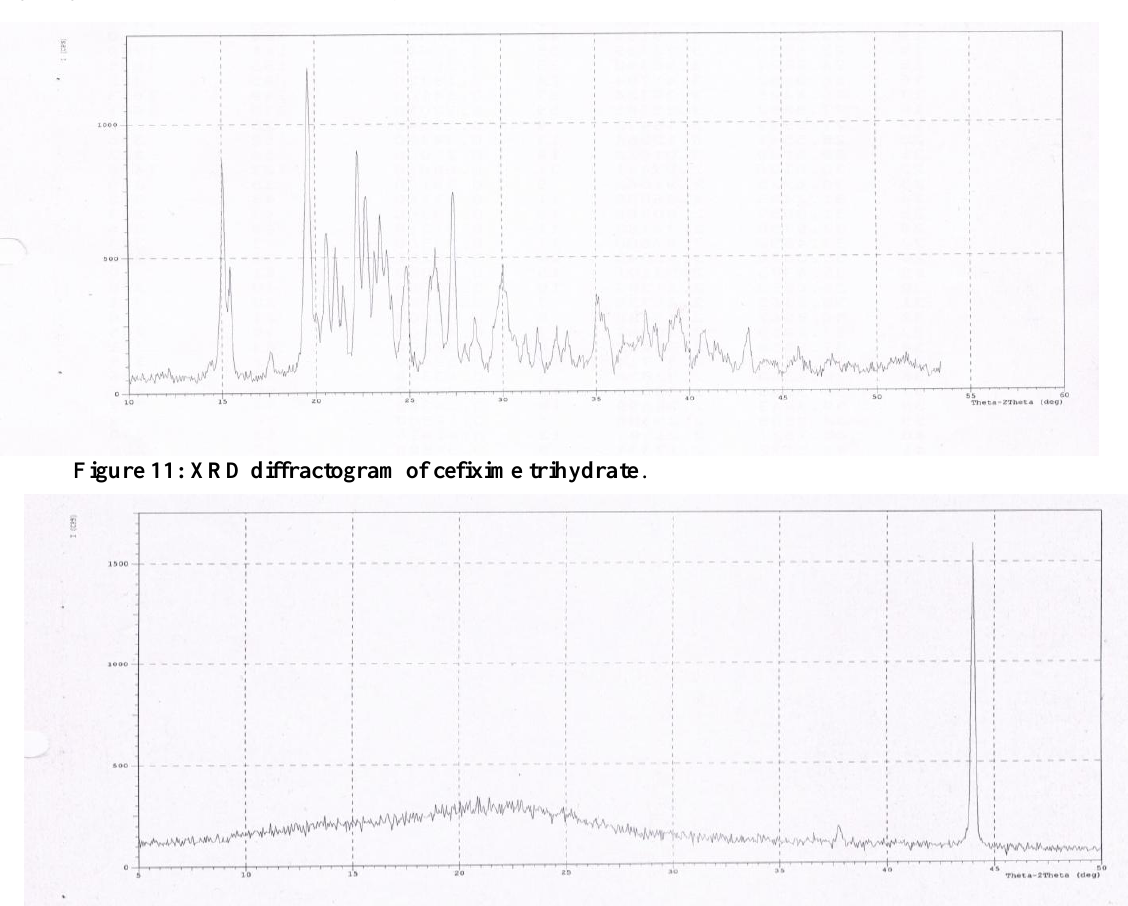
Figure 12: XRD diffractogram of formula 6.